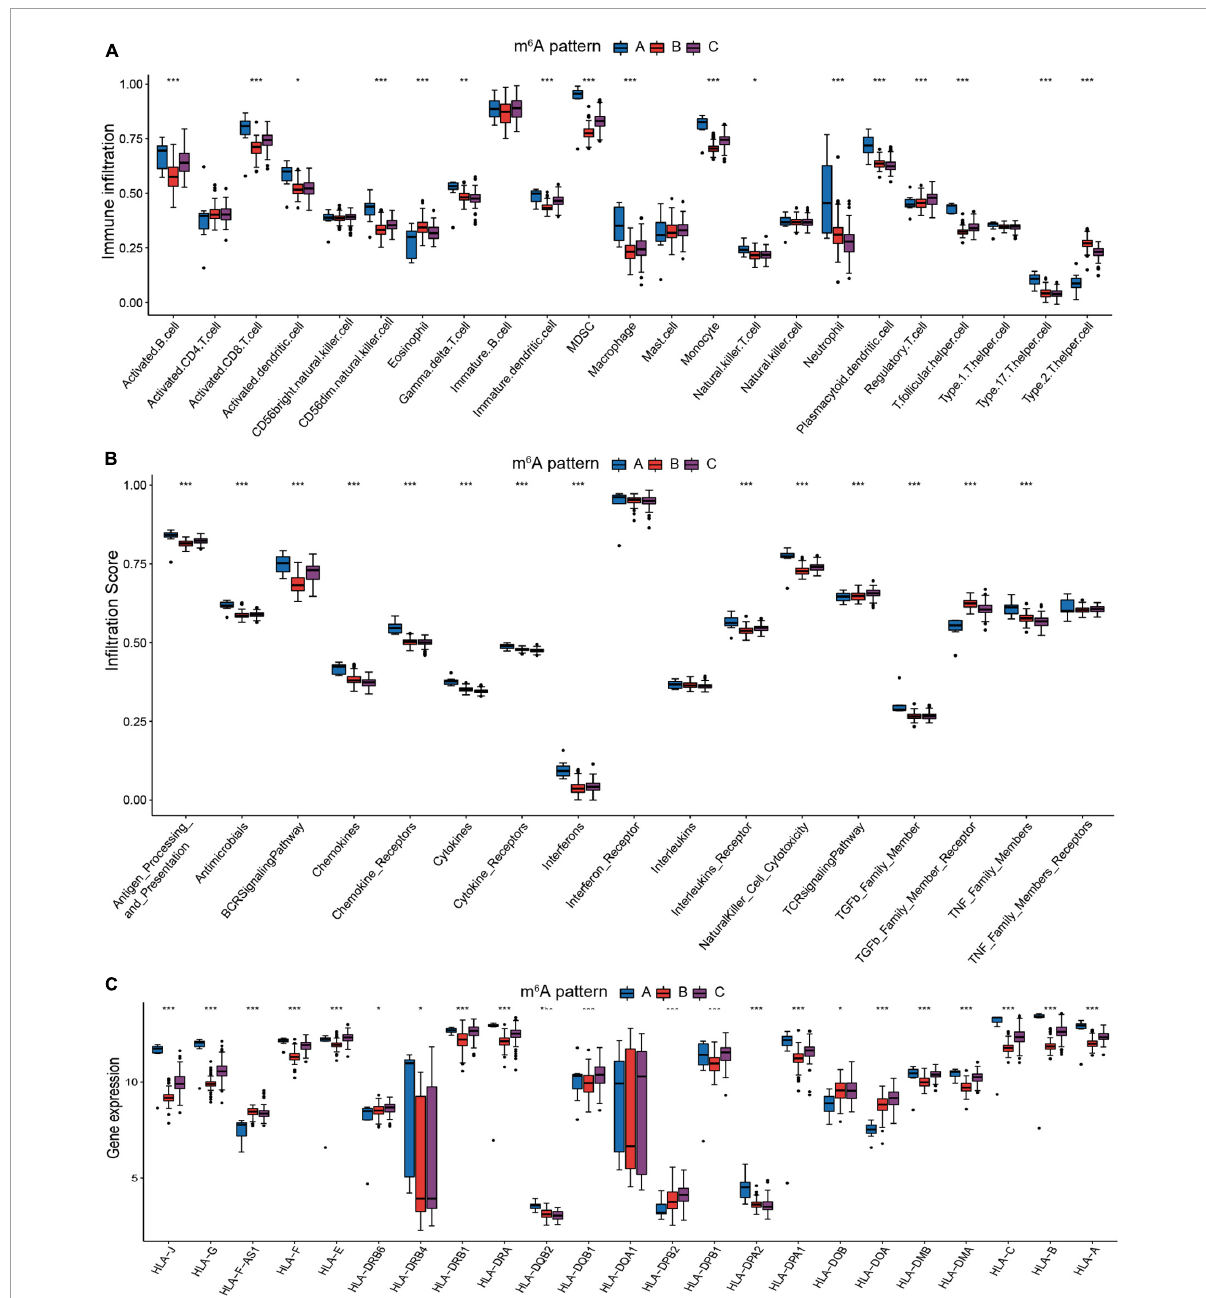
FIGURE5 The immunological microenvironment varies significantly across the three m 6 A patterns. (A) The discrepancies in the abundance of each infiltrating immunocyte in the three m 6 A patterns. (B) The three patterns exhibit varying degrees of immunological response. (C) Human leukocyte antigens (HLA) gene expression varied significantly across the three m 6 A